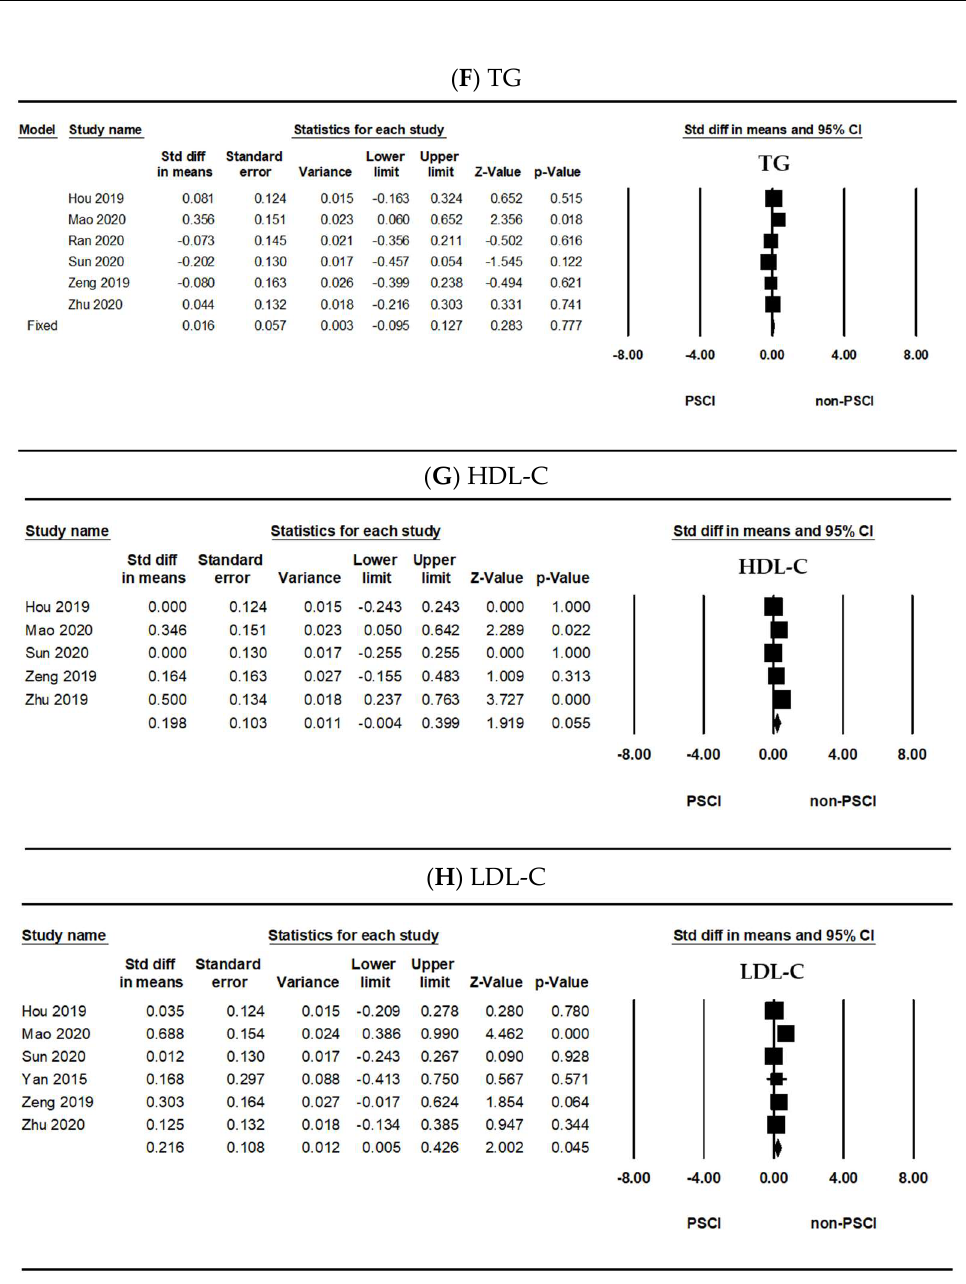
Figure 2. Forest plots of the ( A ) Hcy, ( B ) CRP, ( C ) uric acid, ( D ) HbA1c, ( E ) TC, ( F ) TG, ( G ) HDL-C, and ( H ) LDL-C levels. Hcy: homocysteine, CRP: C-reactive protein, HbA1c: glycated hemoglobin, TC: total cholesterol, TG: triglyceride, HDL-C: high-density lipoprotein cholesterol, LDL-C: low- density lipoprotein cholesterol, Std diff: standard difference, CI: confidence interval, PSCI: post-stroke cognitive impairment.